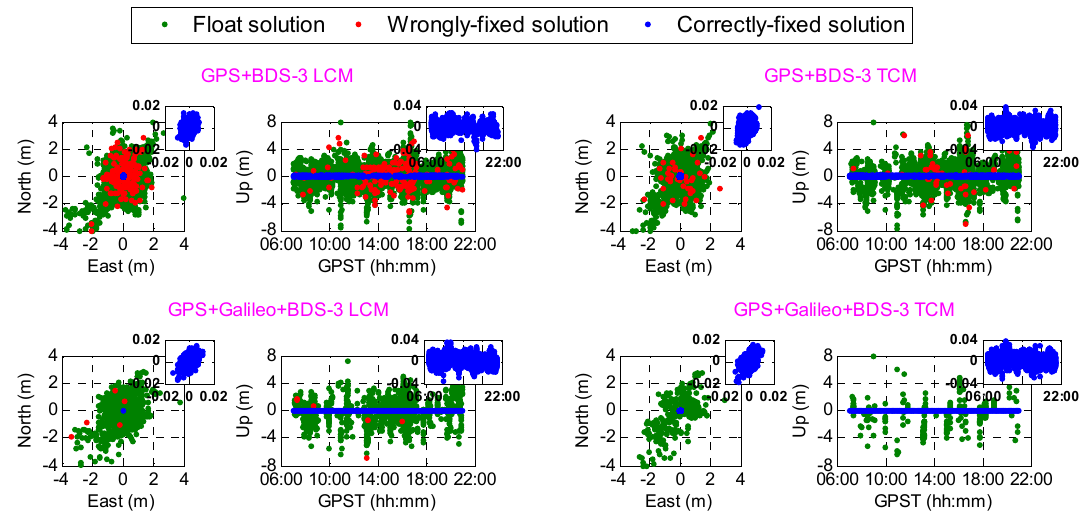
Figure 13. Positioning errors with single-frequency observations under 10 ◦ elevation cut-o ff angle. The ratio threshold of 2.0 is adopted for ambiguity validation.